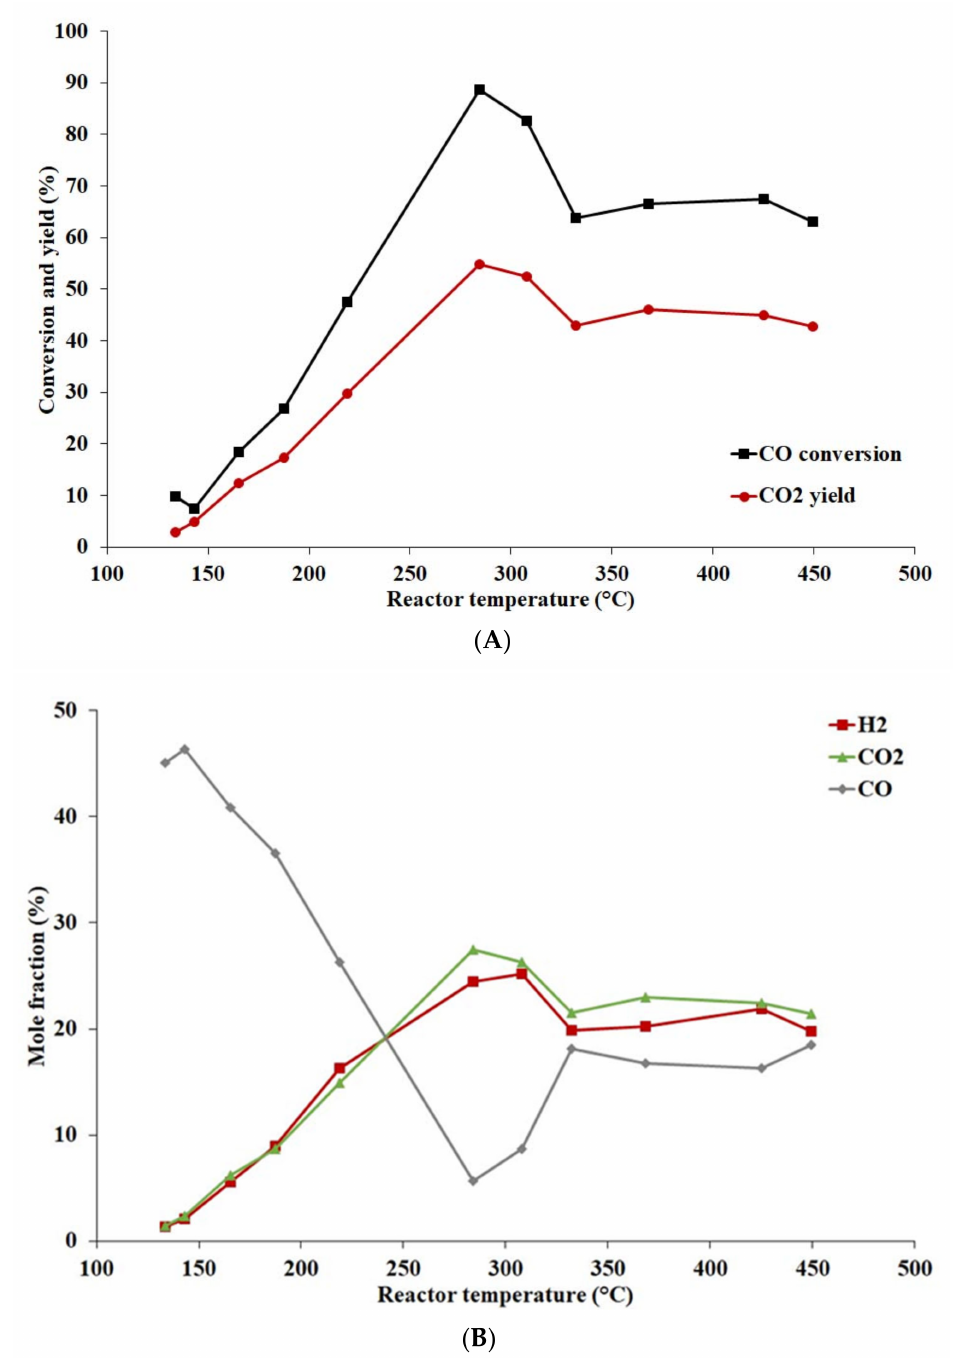
Figure 13. Catalytic tests on a Cu-based (14.8 wt%) activated catalyst, prepared with calcined support, with feed gas mixture 1 (50 mole% CO, 50 mole% N 2 ) at pressure 6 MPa; flow rate 6 L min − 1 : ( A )—CO conversion and CO 2 yield; ( B )—composition of the gas